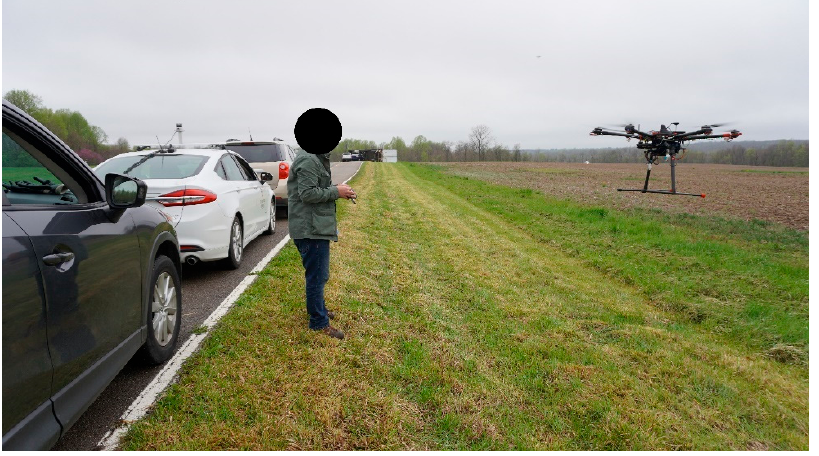
Figure 7. The field experiment with CAV and UAV.